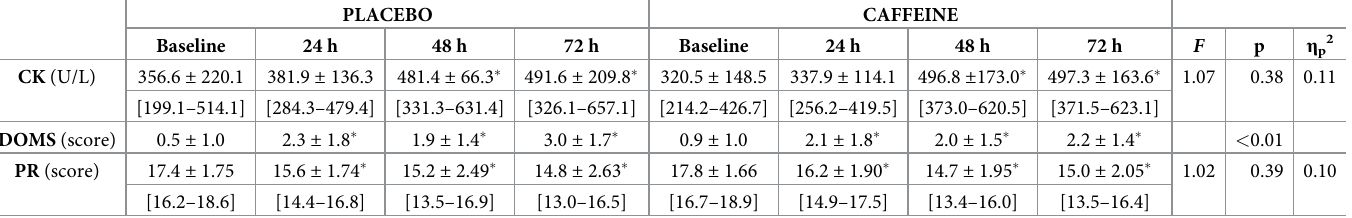
Table 1. Creatine kinase, delayed onset muscle soreness and perceived recovery at baseline, and at 24, 48 and 72 h later a half-squat exercise with placebo or caffeine